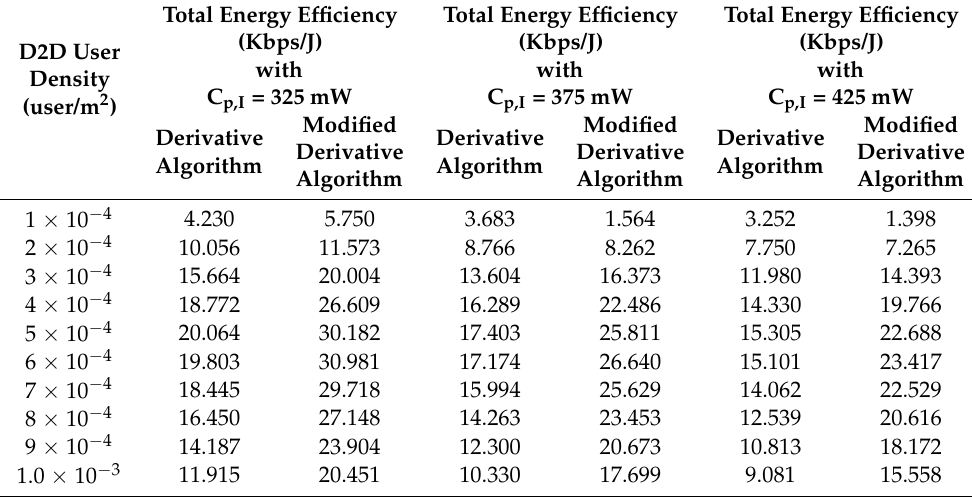
Table 4. Comparison of energy efficiency with the D2D density users (users/m 2 ).